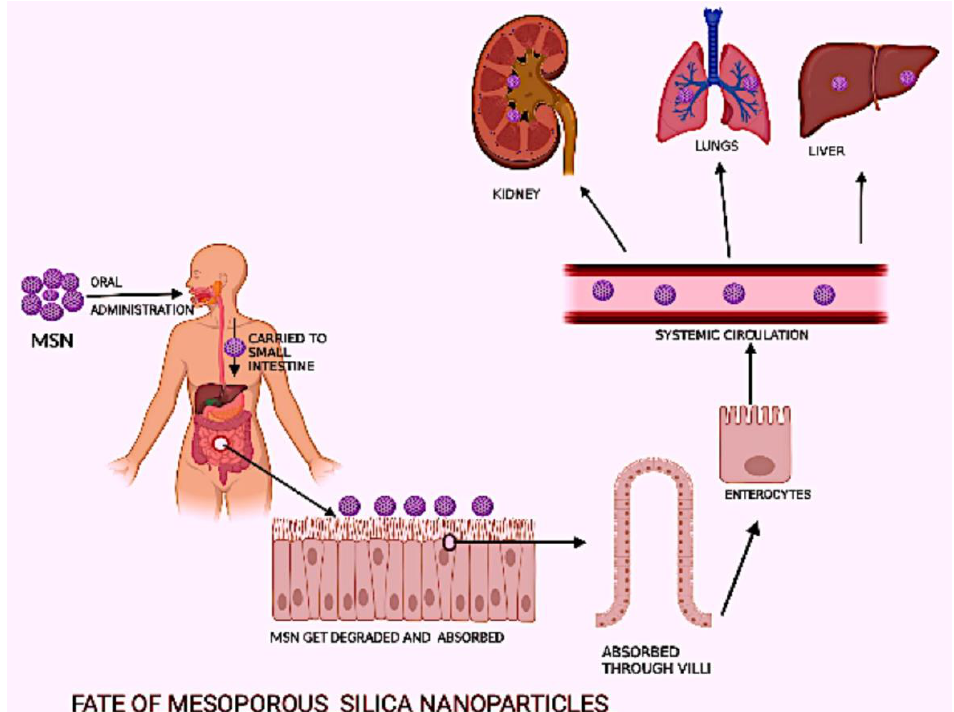
Figure 7. Fate of mesoporous silica nanoparticles.